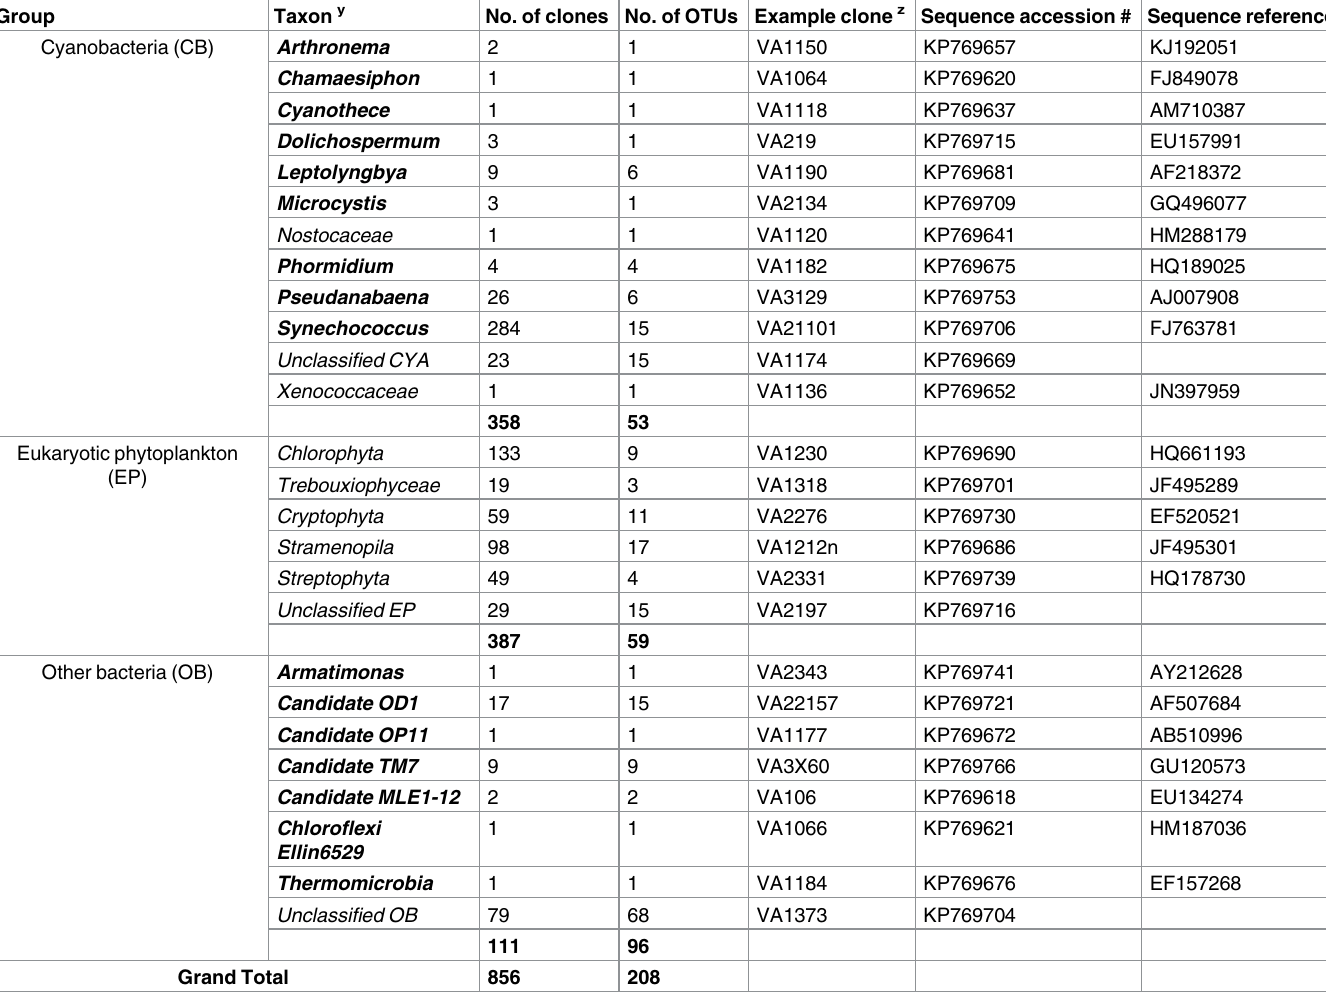
Table 2. Summaryof taxa identified from eight reservoirsand an adjacent streamby sequencing the 16S rDNA.